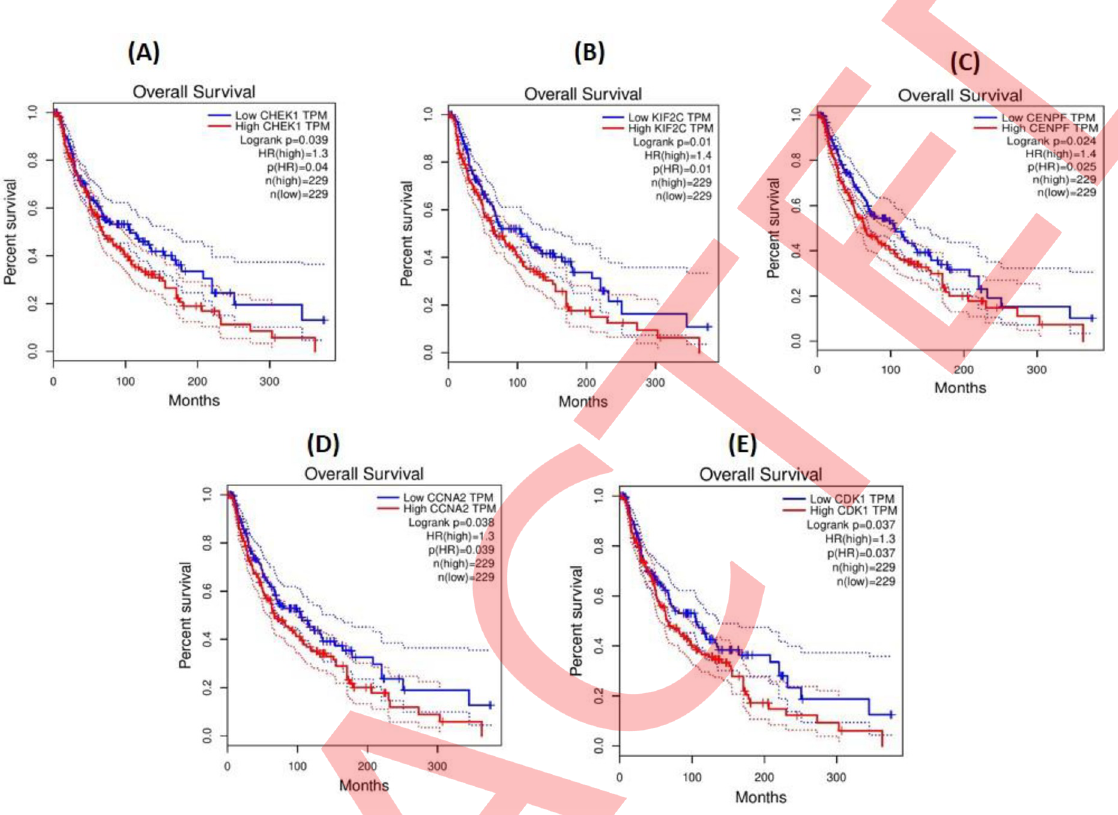
Fig 6. Survival analysis of CHEK1, KIF2C, CENPF, CCNA2, and CDK1 in GEPIA server.